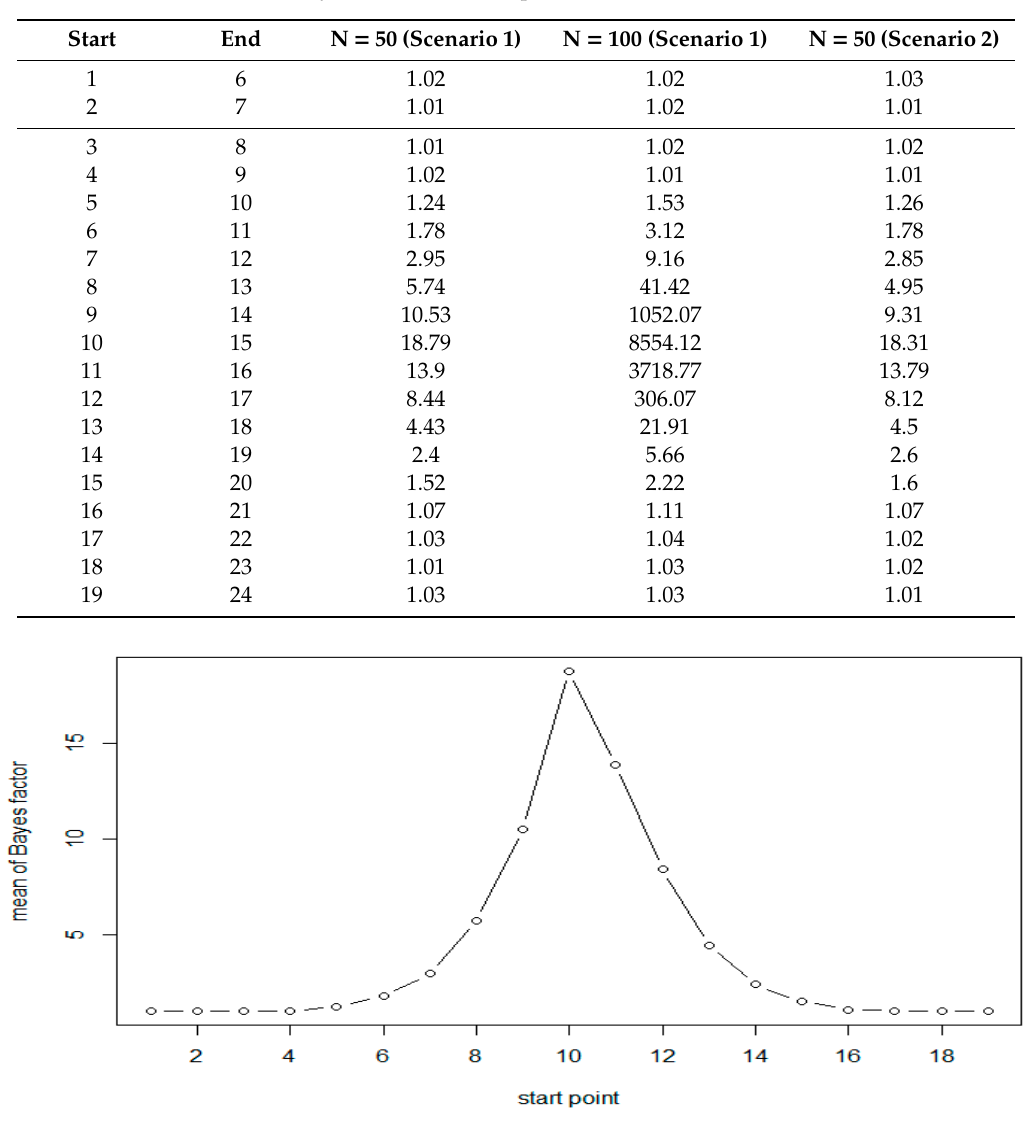
Figure 1. Mean of Bayes factors at each CpG site with N = 50 (Scenario 1).